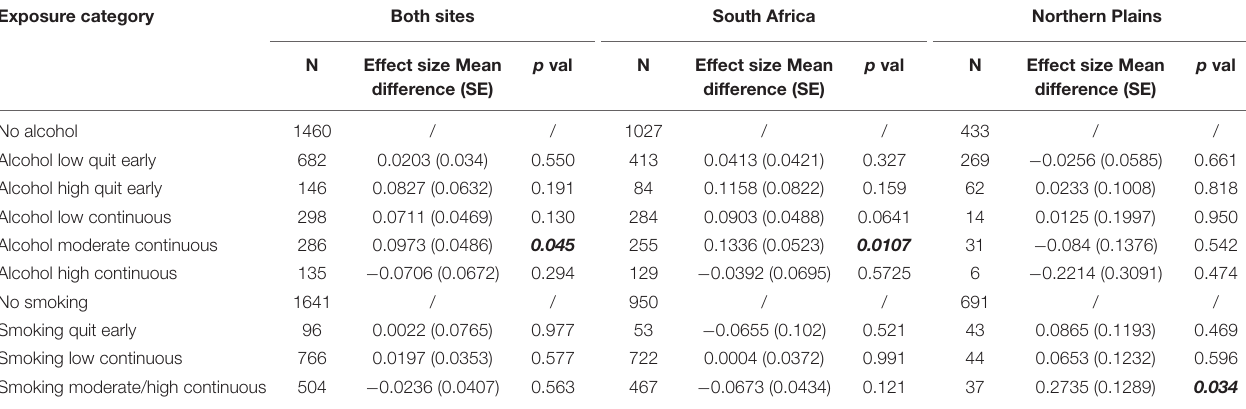
TABLE 7 | Linear regression results from alcohol and smoking exposure predicting HR-SD in 1F. Exposure category